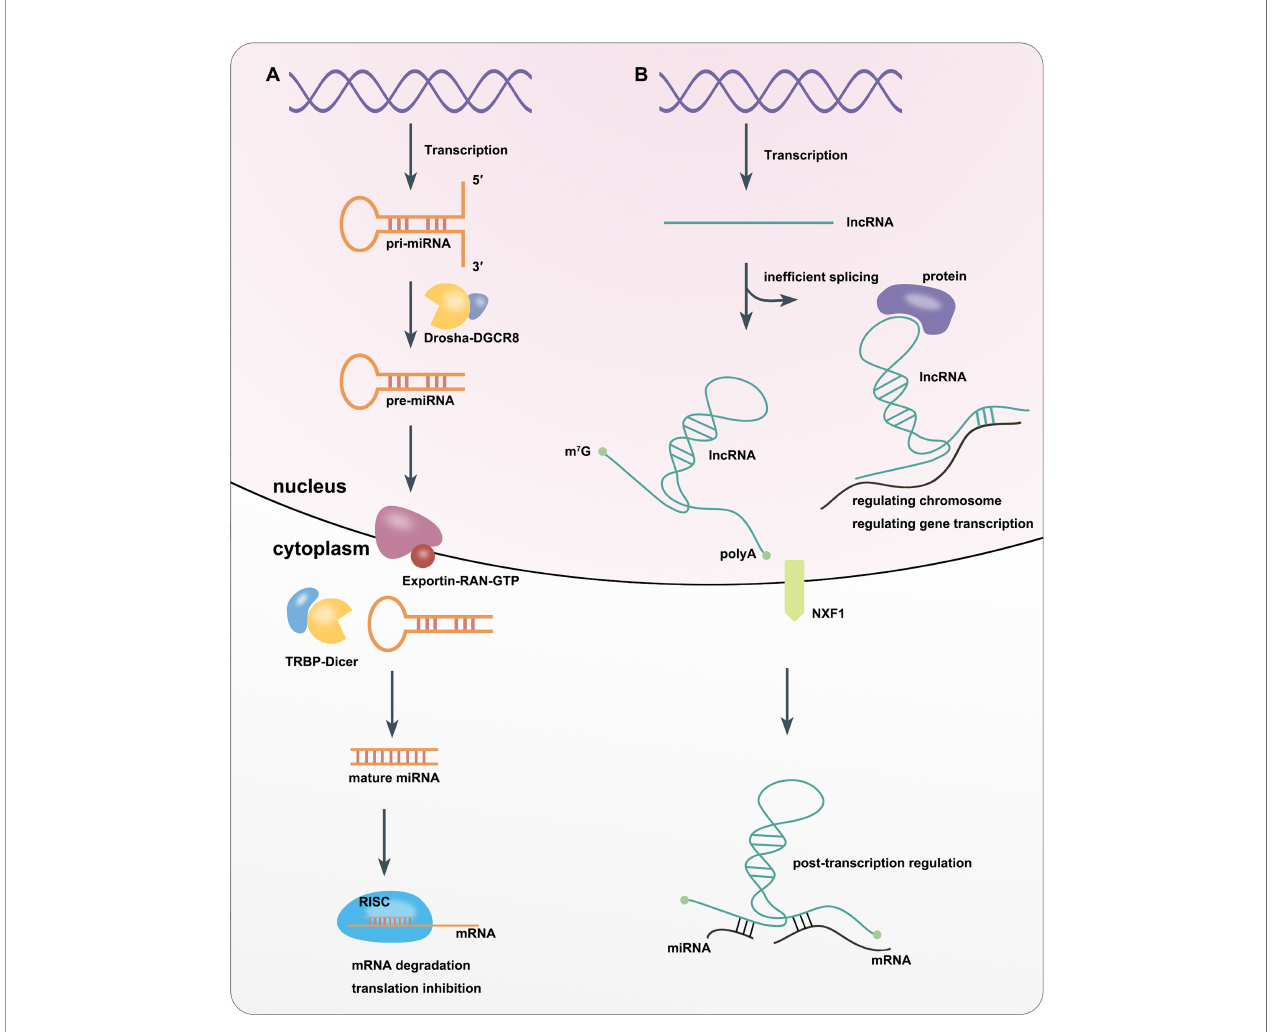
FIGURE 1 | Biosynthesis and Function of miRNA (A) and lncRNA (B)